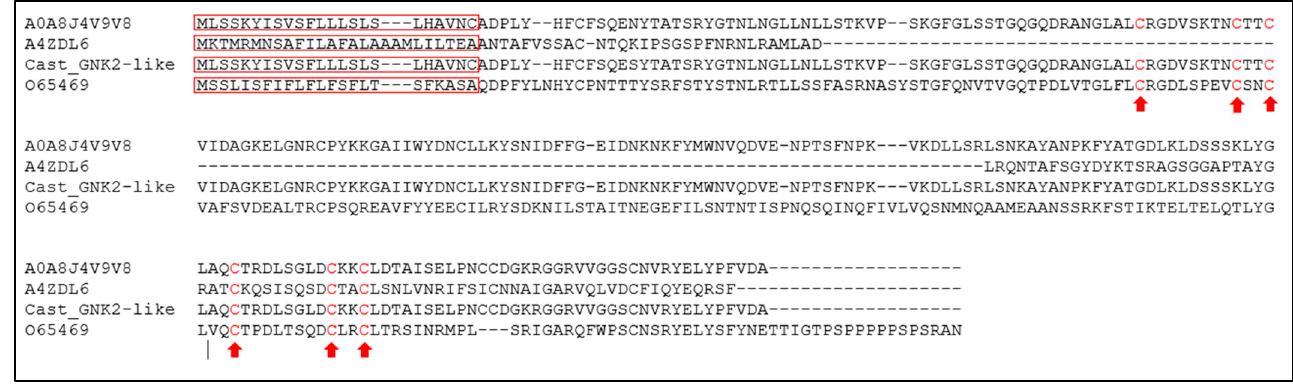
Figure 2. A multiple alignment of C. crenata putative Ginkbilobin-2 protein (Cast_GNK2-like), C. mollissima Cysteine-rich repeat secretory protein 38 (A0A8J4V9V8), Ginkgo biloba Antifungal protein ginkbilobin-2 (A4ZDL6), and A. thaliana Putative cysteine-rich receptor-like protein kinase 9 (O65469), with CLUSTALW [17]. Protein accession numbers are indicated (Uniprot Accession). The signal peptide is surrounded by a red box and the conserved cysteine motif (C-8X-C-2X-C) is indicated in red. Table 1. In silico characteristics of the amino acid sequences homologous to Ginkbilobin-2. N.d.: non-determined. Pos: position of the signal